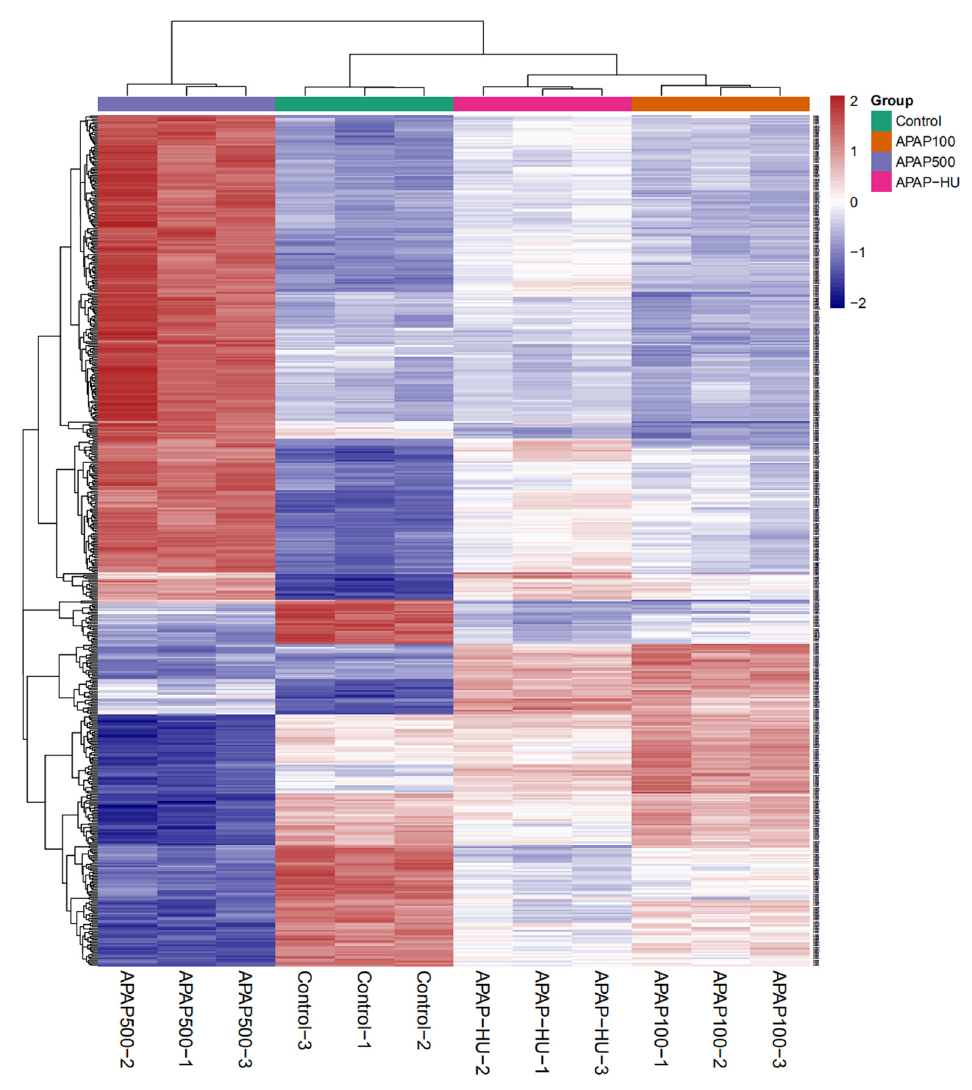
Figure 5. Clustering analysis of differentially expressed proteins of macrophages treated with acetaminophen (APAP) in the presence or absence of polydatin